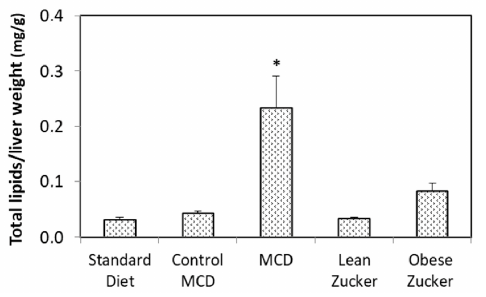
Figure 8. Total lipids in Wistar, MCD, and Zucker rats. The values are means ± SE, n = 7/group. * <0.03 versus obese Zucker rats.